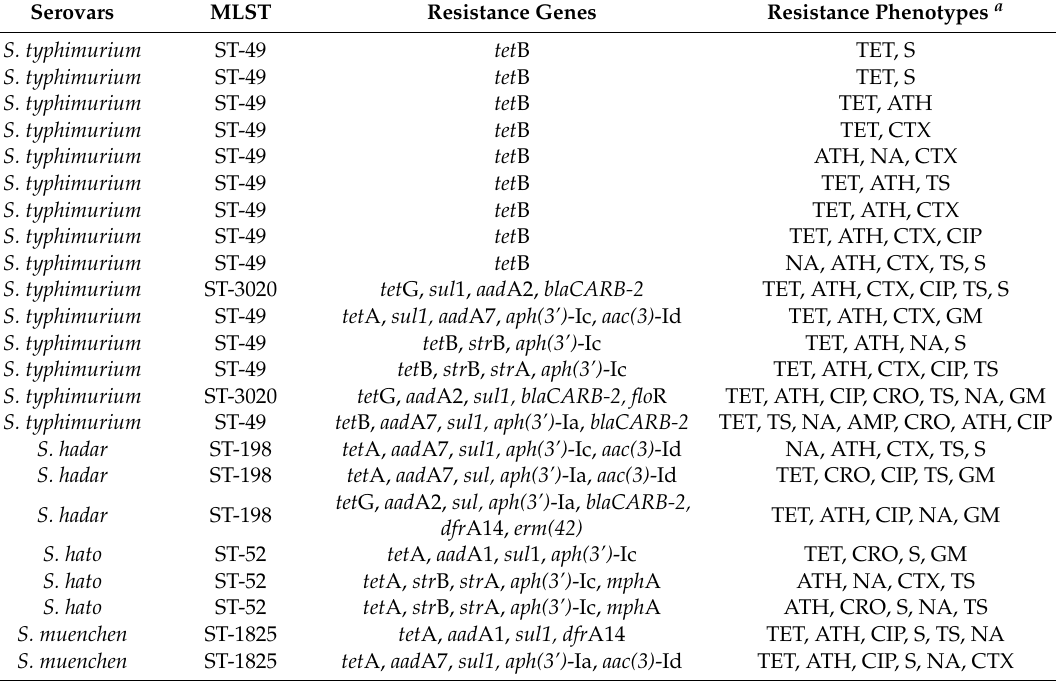
Table 4. Whole-genome sequencing (WGS)-derived typing data and resistance phenotype among Salmonella ( n = 23) isolated from diarrheal cases ( n = 155) among children < 5 years. Serovars MLST Resistance Genes Resistance Phenotypes